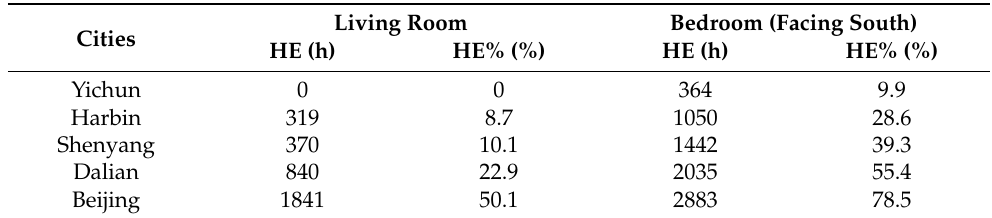
Table 11. Overheating duration of the simulated occupied flat (on the 9th floor) during summertime over 15 years (2004 to 2018). Living Cities